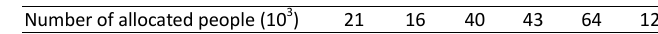
Table 4: Allocated people to shelters Shelter